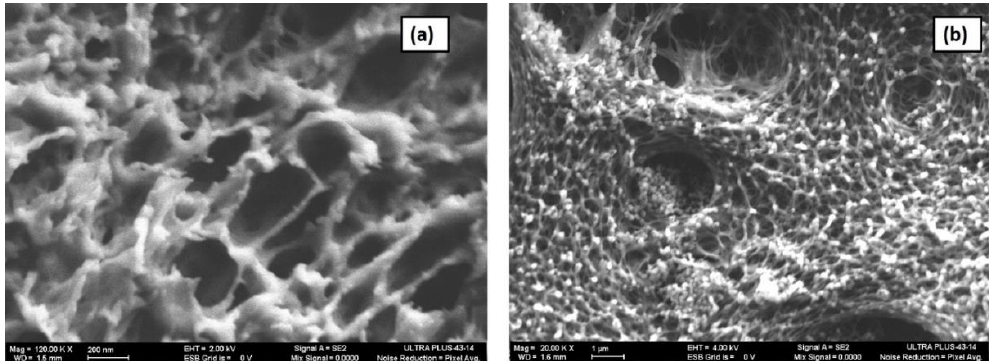
Figure 7. ( a ) Outer surface of the SBP capsule. ( b ) Cross-section of SBP capsule membrane.